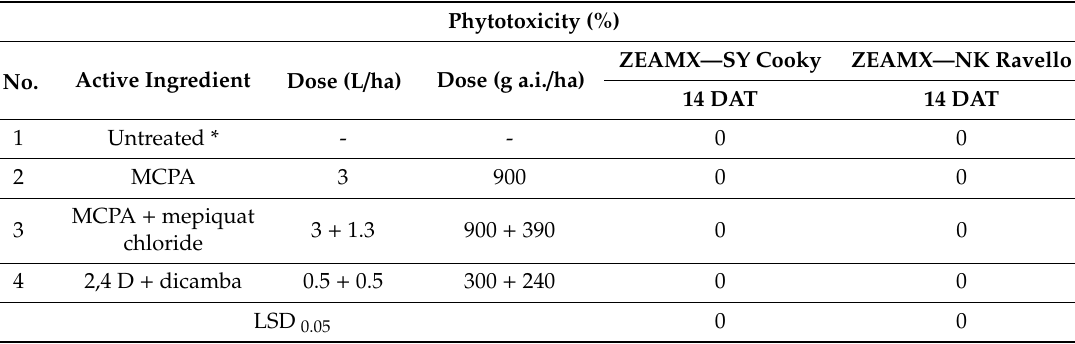
Table 6. Sensitivity of two maize varieties to di ff erent herbicide